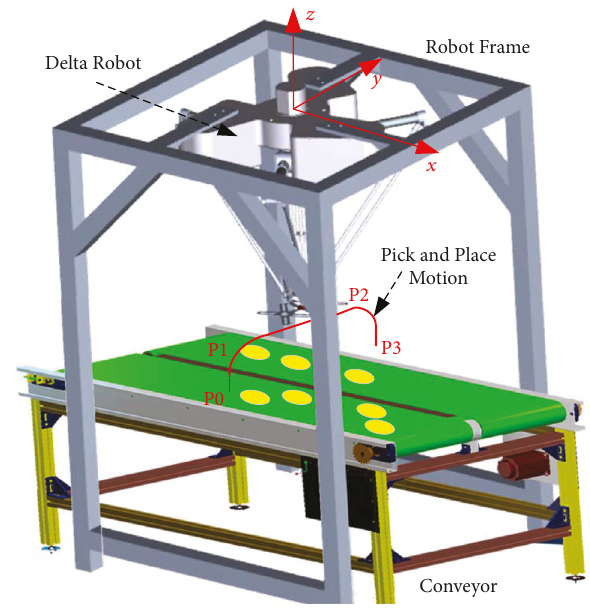
Figure 1: The Delta robot based pick and place work cell.